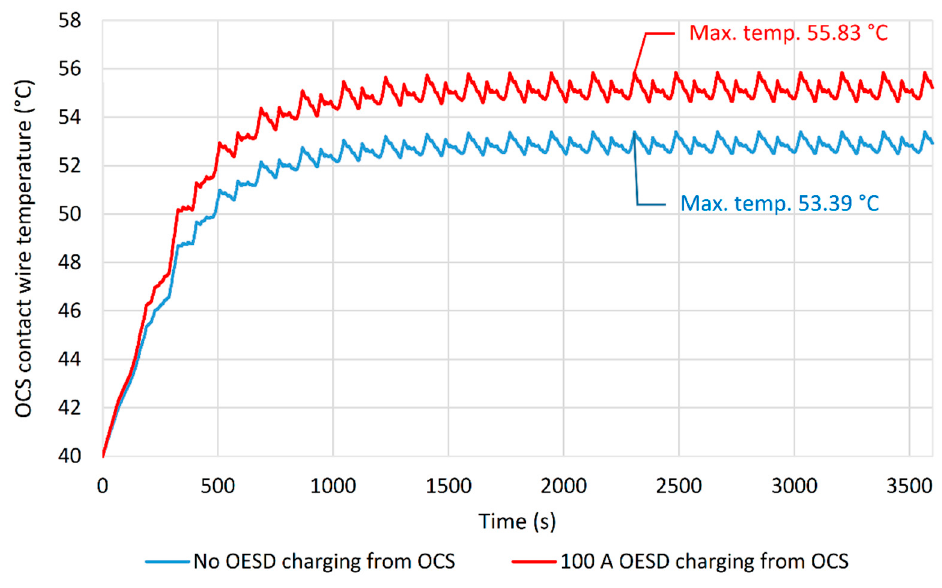
Figure 13. Maximum contact wire temperature between Station B and Station C.